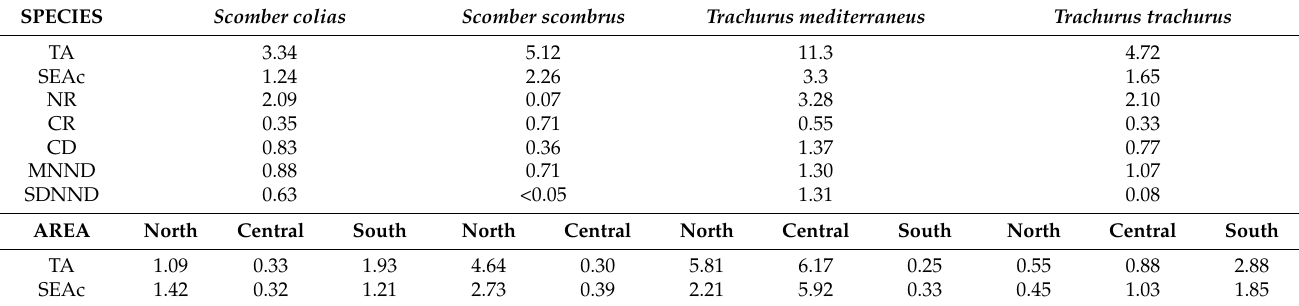
Table 3. Values of Total Area of the convex hull (TA) and of the corrected Standard Ellipse Area (SEA C ) obtained considering the four different “ancillary” species and the areas in which they were caught. Values of TA and SEA C are expressed as ‰ 2 . Other values are shown in the table: mean distance to centroid (CD), δ 15 N range (NR), δ 13 C range (CR), mean nearest neighbor distance (MNND) and standard deviation of the nearest neighbor distance